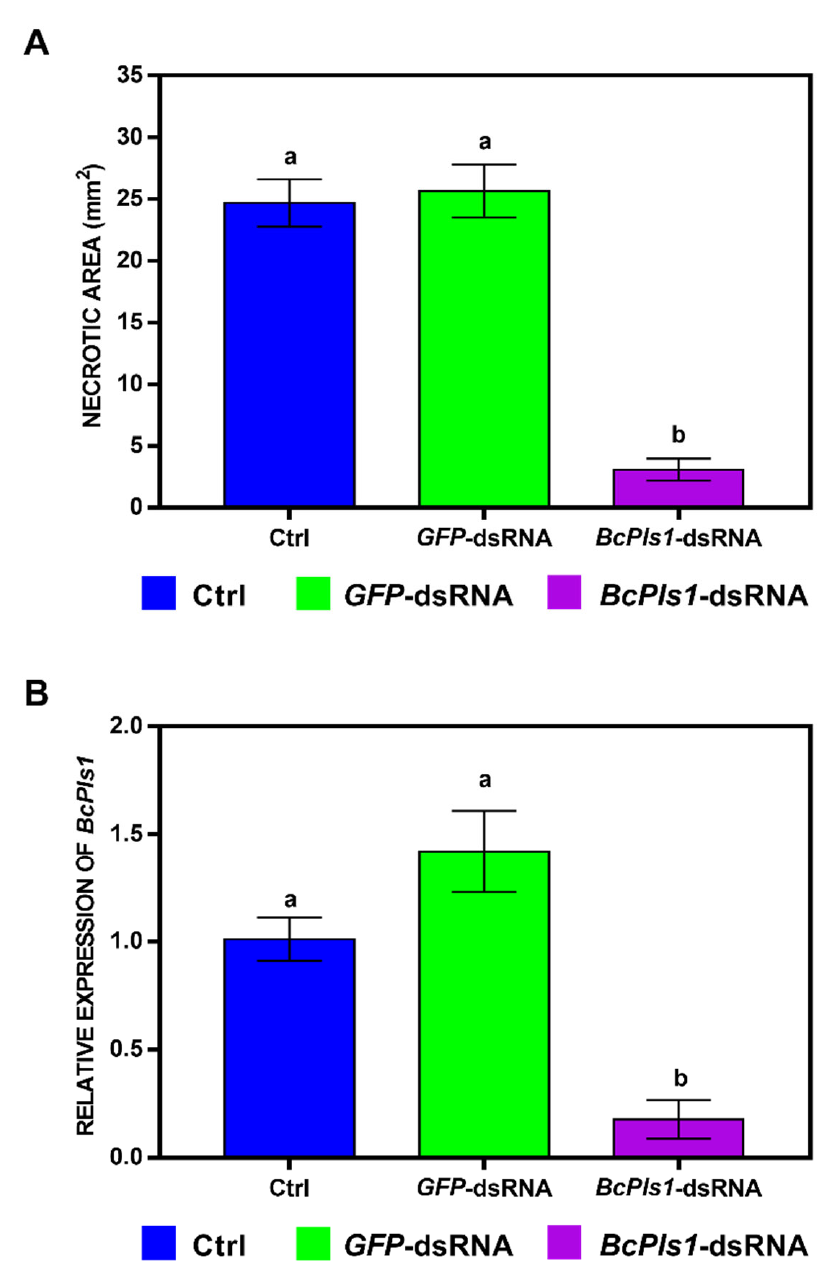
Figure 6. ( A ) Necrotic areas (in mm 2 ) caused by B. cinerea at 5 dpi measured using the ImageJ software, version 1.53a. Leaves were treated with water + TE (Ctrl, blue), GFP -dsRNA (green), or BcPls1 -dsRNA (purple) and were then artificially inoculated with a conidial suspension (5 × 10 2 spores) of the pathogen. The graph shows the mean ( ± SE) values of two independent experiments with sixteen biological replicates ( n = 16). ( B ) Relative transcript values of BcPls1 (purple) at 5 dpi were calculated by qRT-PCR using GFP -dsRNA (green) and Ctrl (blue) as reference samples and were normalized to the GAPDH gene of Lactuca sativa ( LsGAPDH ). The graph shows the mean ( ± SE) values of three biological replicates ( n = 3). Same letters above the bars indicate no significant differences from each other (ANOVA) according to Tukey’s HSD test ( p ≤ 0.05).